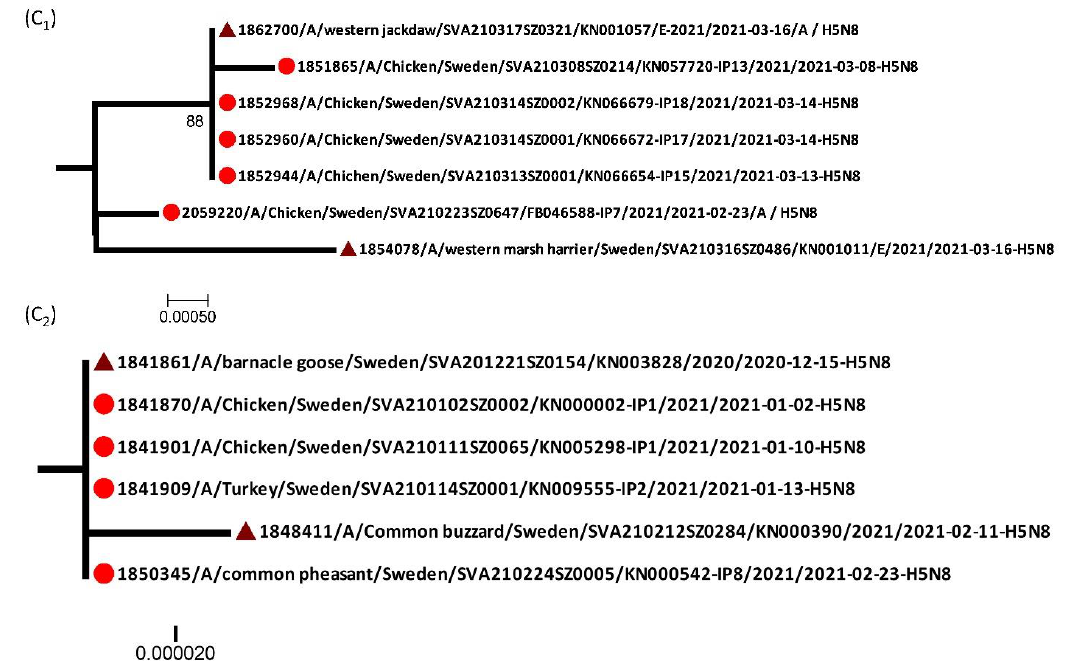
Figure 5. Maximum-likelihood phylogenetic tree for the NA gene. ( A ) The phylogenetic tree was constructed with H5Nx viruses reported in Europe ( n = 813) during the influenza season 2020 – 2021. Viruses detected in Sweden are indicated by red text. ( B ) The phylogenetic tree was constructed with H5Nx viruses detected in Sweden ( n = 91) during the influenza season 2020 – 2021. Red solid triangles indicate the samples from the wild birds and red solid circles are indicating the samples from poultry and captive birds. ( C 1 , C 2 ) Genetic relationship between sequences of detected viruses in the cluster of farms IP1 and IP2 and in the cluster of neighbouring farms IP13, IP15, IP17 and IP18. Bootstrap values (2000 replicates) >70% are displayed at the branch nodes. The scale bar indicates the number of nucleotide substitutions per site.